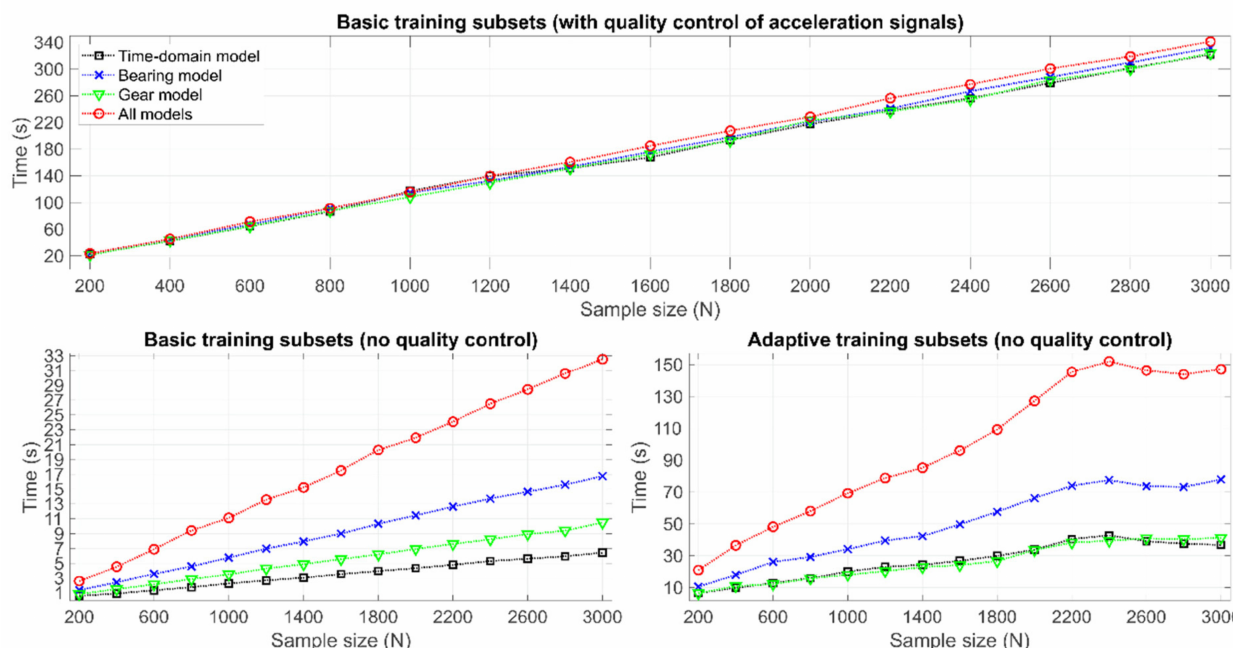
Figure 11. Time used in algorithm training. Plot on top shows entire computation time when ‘basic training subsets’ approach was used. Plots below show corresponding computation time without quality control using ‘basic training subsets’ (left) and ‘adaptive training subsets’ (right). Note that vertical axes have different